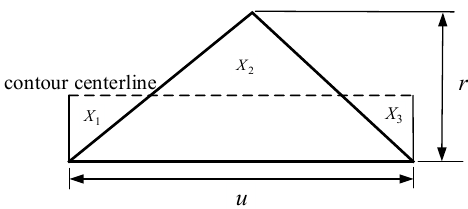
Figure 4. SRPF-HB model schematic.